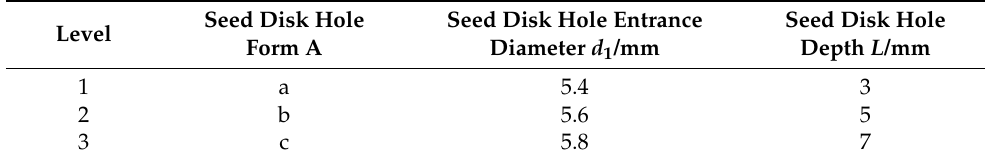
Table 1. Factors and levels of orthogonal experiments.